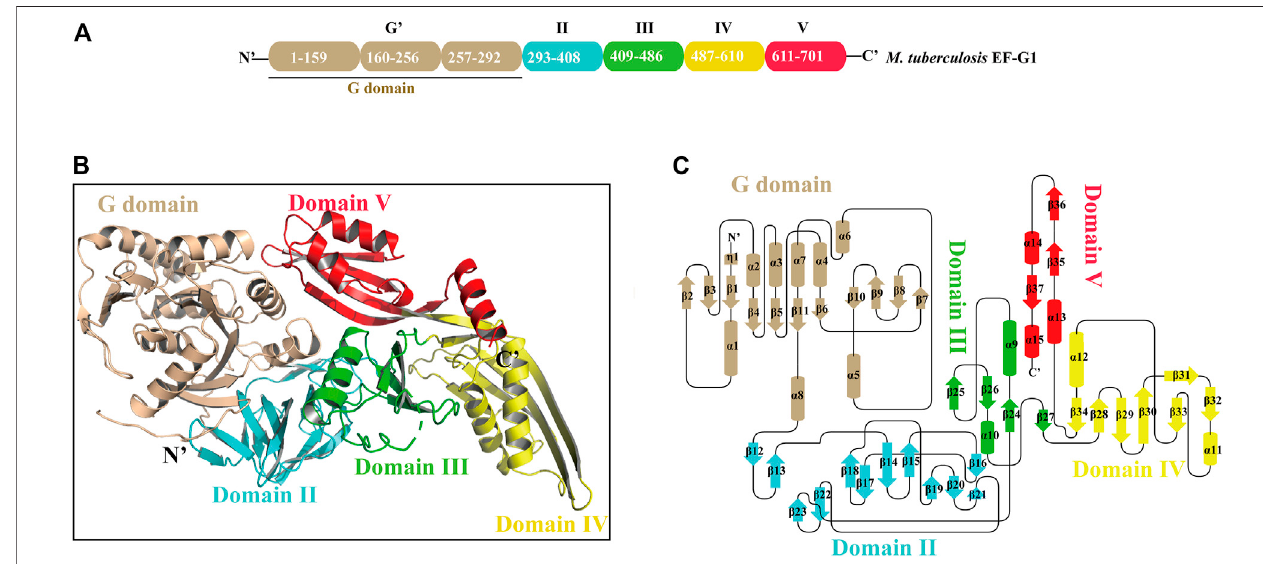
FIGURE 1 | The overall structure of Mtb EF-G1. (A) Domain organization of Mtb EF-G1. (B) Ribbon model of the Mtb EF-G1 crystal structure. The individual domainsaredifferentlycolored,withGdomain inwheat,domain IIincyan, domainIII ingreen,domain IVinyellow anddomain Vinred. (C) TopologydiagramofMtbEF- G1.The domains are colored the same as in panel (B)